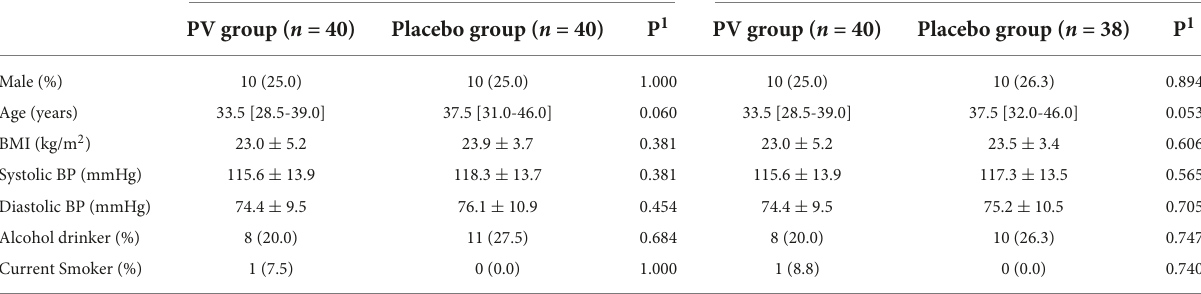
TABLE 1 Baseline characteristics of the study